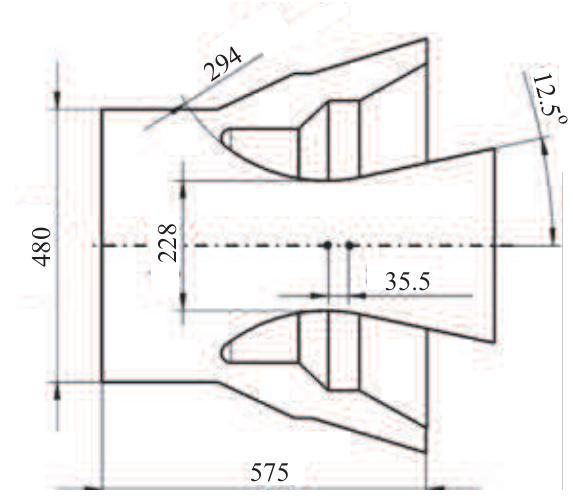
Figure 1. Geometrical